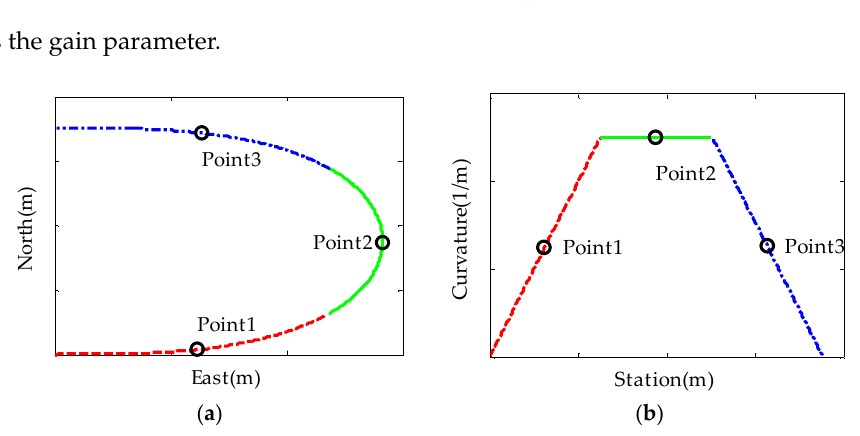
Figure 6. ( a ) The designed path and ( b ) the corresponding path curvature varies along the path. The simulation is carried out with sampling time T s = 0.02 s, and the simulated steering angle and the corresponding front lateral force are shown in Figure 7.